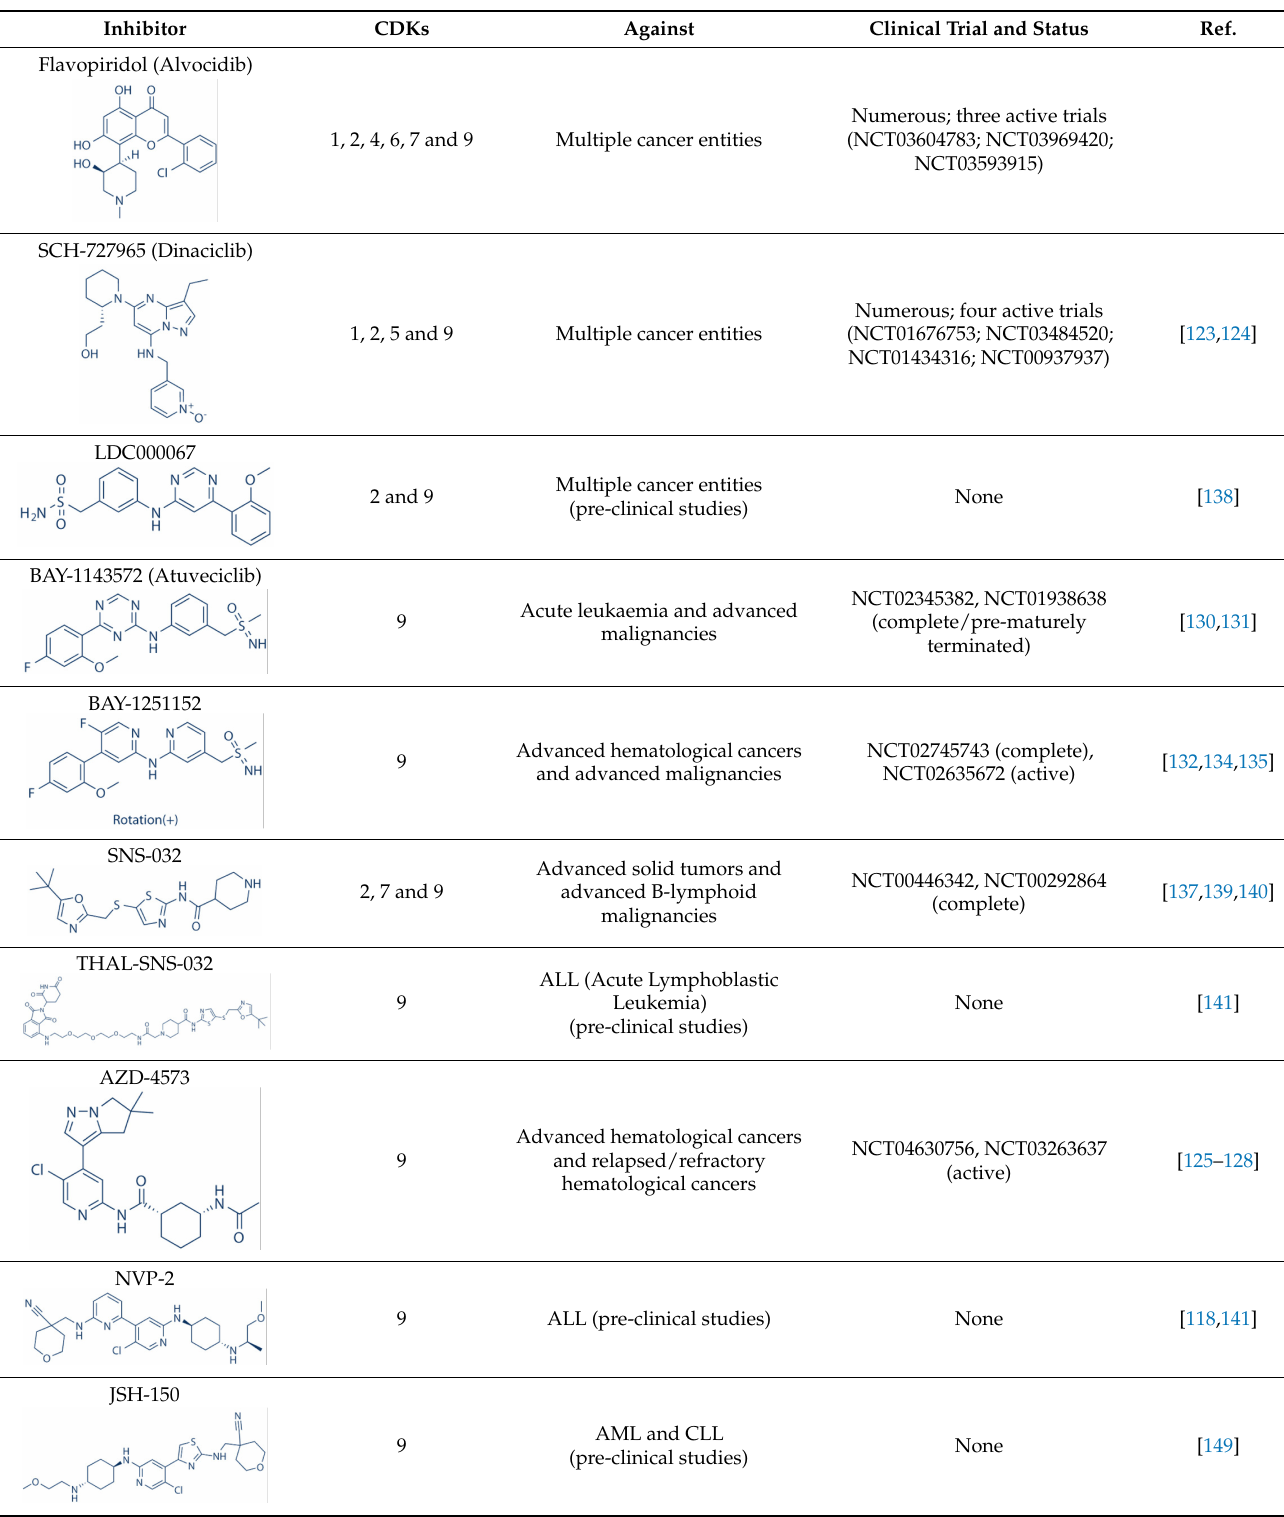
Table 2. The various CDK9 inhibitors, their target kinase (s), cancer entities they were tested against (includes pre-clinical trials where clinical trials were never performed) and their clinical trials (wherever performed). Source: www.clinicaltrials. gov (accessed on 12 February